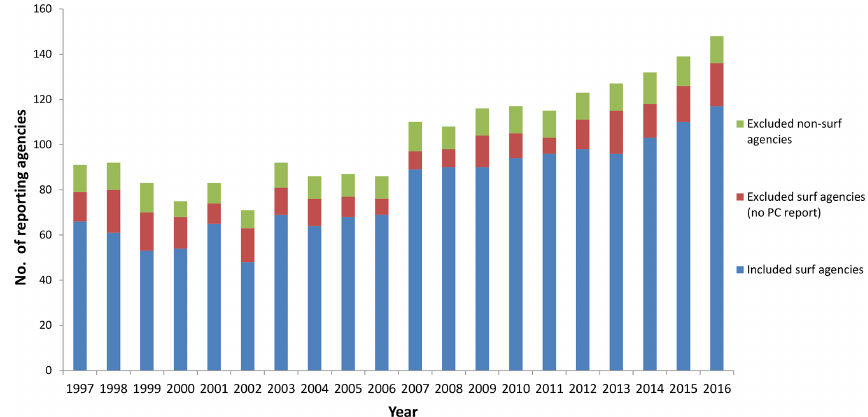
Figure 1. The number of lifeguard agencies reporting to the United States Lifesaving Association (USLA) statistics database between 1997 and 2016. Included surf agencies report primary cause (PC) of rescues. Table 1. Primary causes of rescues on surf beaches reported to the USLA statistic database in 1997–2016 by coastal region in the US. The percent of rescues by primary cause are indicated in parentheses. The Great Lakes are not included as, with one minor exception, rescue data from the Great Lakes do not include primary cause of rescue. Rescues by region Region All Rip current